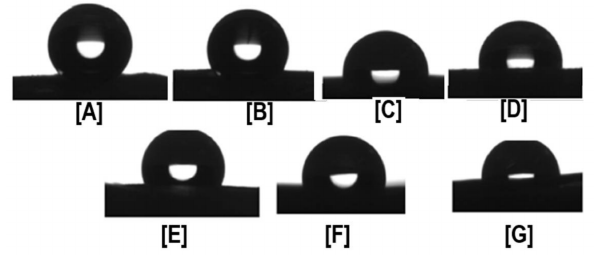
Figure 3. Water Contact Angle (WCA) values of PCL, PCL/ α -CD, and PCL/ γ -CD functionalized nanofibers. The neat PCL showed hydrophobic characteristics (WCA of 140 ◦ ), while the WCA of functionalized nanofibers showed a marked decrease in hydrophobic characteristics, even with the addition of as little as 5% CD (WCA of PCL/5% α -CD and PCL/5% γ -CD are ~120 ◦ ). With further addition, WCA plateaued at ~100 ◦ , depending on the CD used. Images adapted and reproduced with permission from [43]. Copyright American Chemical Society